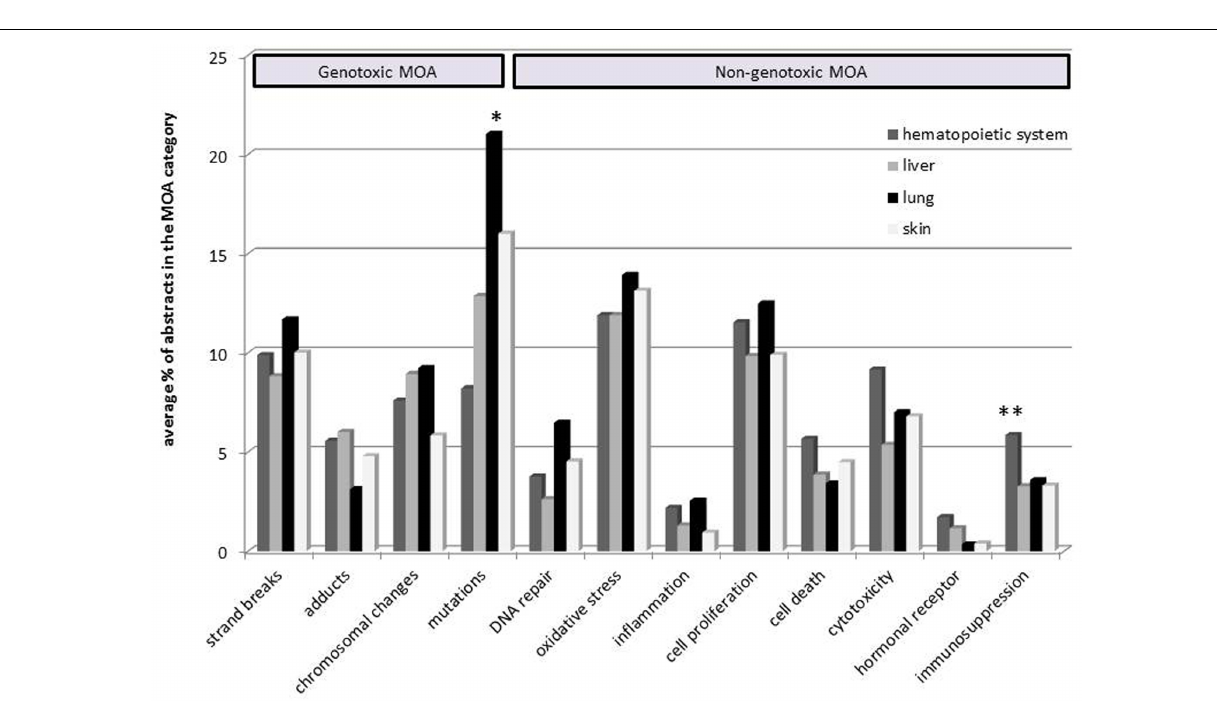
Frontiers in Pharmacology |